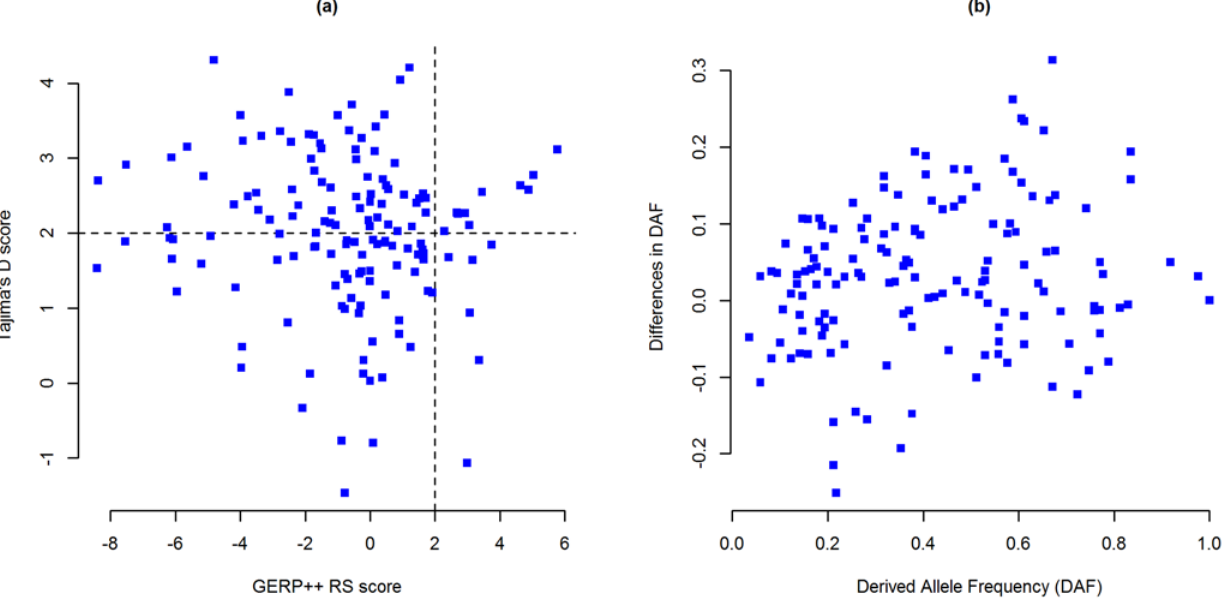
Fig 1. Selective constraints on IBD associated lead noncoding SNPs. ( a ) Evolutionary conservation versus human specific selection on lead SNPs. Evolutionary conservation is presented by GERP++ RS scores ( x axis ) and human specific selection is presented by Tajima ’ s D scores ( y axis ). Each point represents a single SNP; n = 148 SNPs. Positive GERP++ and TD scores indicate regions under negative selection and negative scores indicate positive selection. SNPs in the top-right segment are under strong evolutionary constraint as well as human specific selection. ( b ) Cross-population diversity of lead SNPs between CEU population and rest of the world. DAF is presented in the x axis and Δ DAF is presented in y axis . Each point represents a single SNP; n = 148 SNPs. GERP++ RS : Genomic Evolutionary Rate Profiling rejected substitution; TD : Tajima ’ s D; DAF : Derived allele frequency; Δ DAF : Difference in derived allele frequency; CEU : Utah residents with ancestry from Northern and Western Europe. TD, DAF and Δ DAF statistics are for 1K Genomes Project ’ s CEU population.